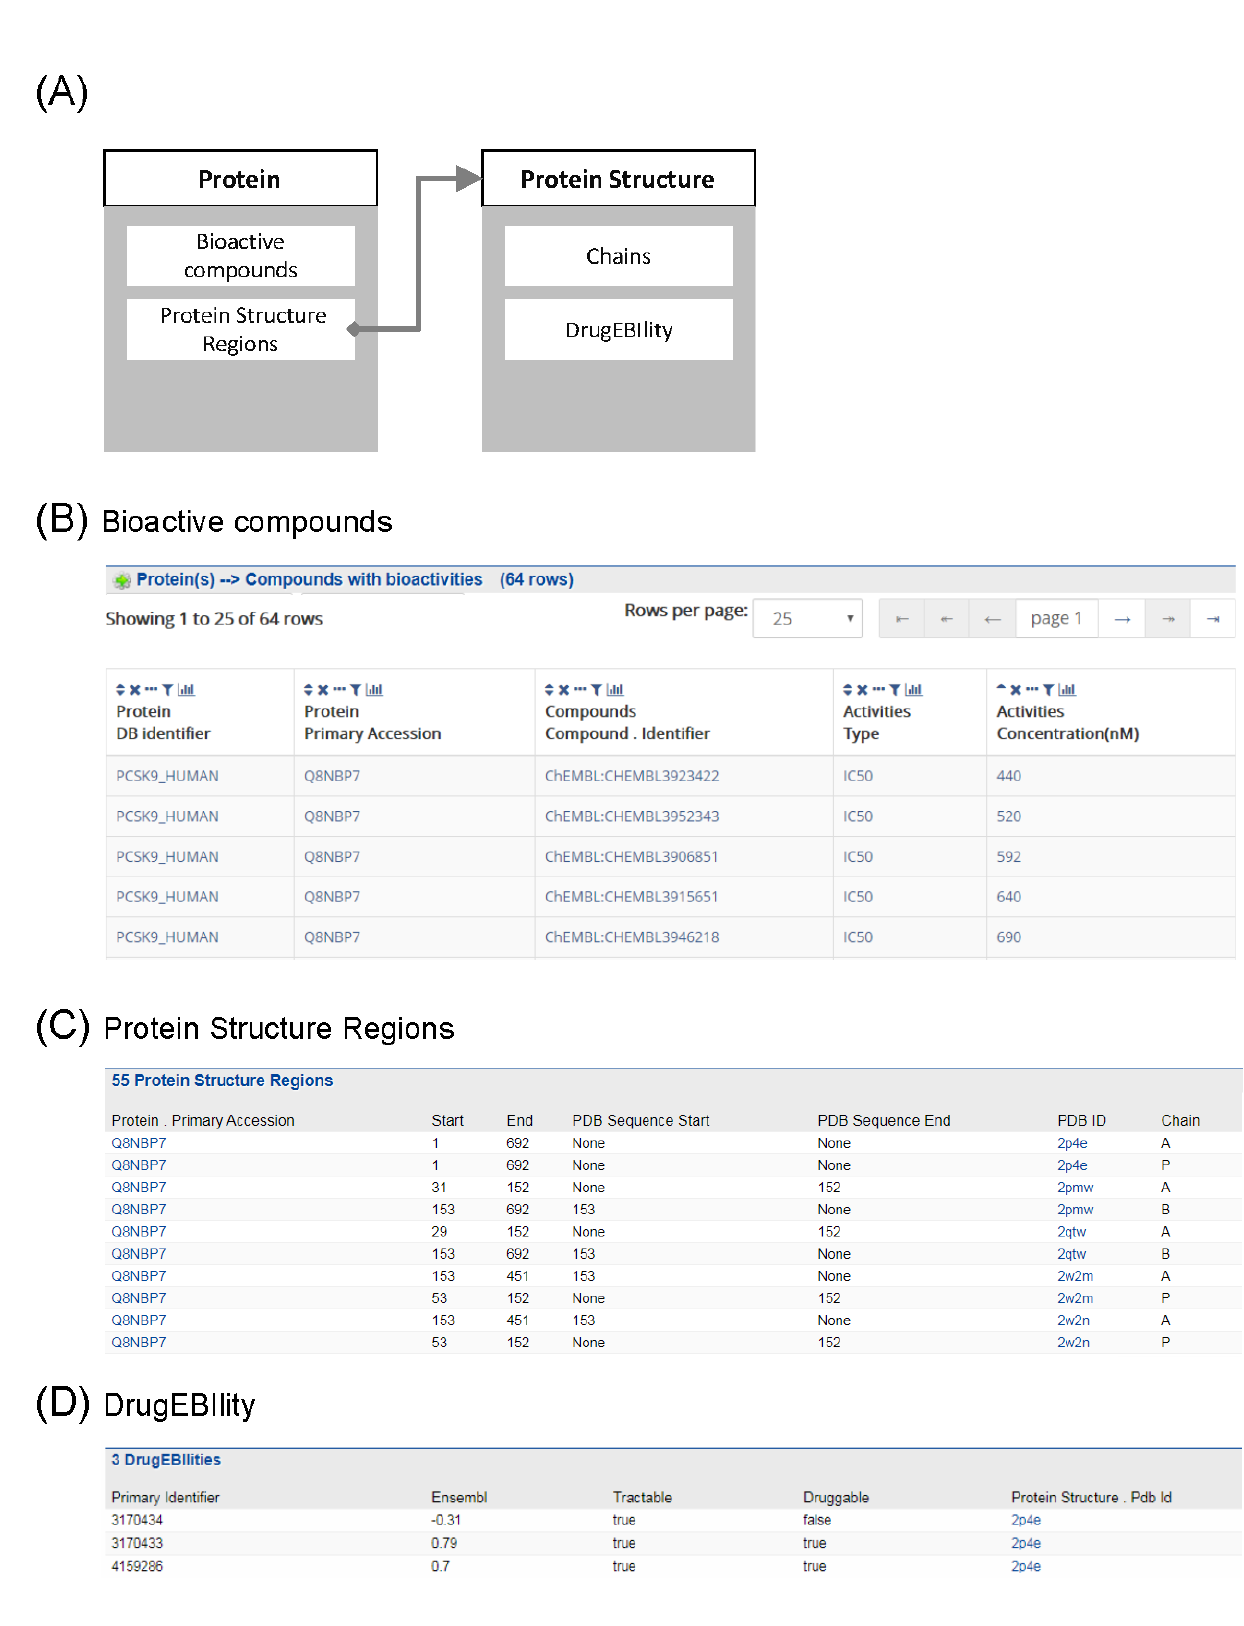
Figure 4. Searching information about target tractability for small molecule drug with TargetMine. ( A ) Outline of the procedure for searching. ( B ) Protein structure regions and their ensemble scores calculated by DrugEBIlity. ( C ) Compounds with bioactivity for PCSK9.